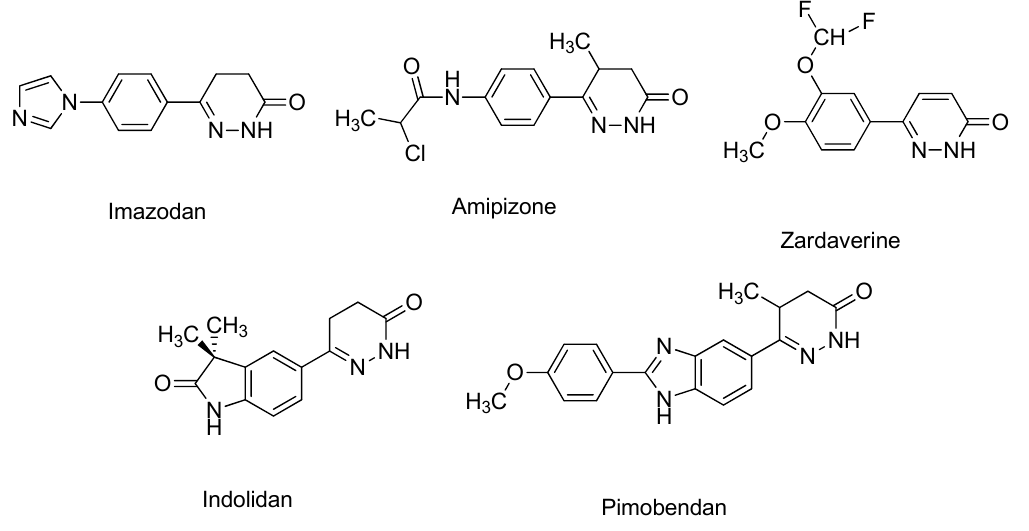
Figure 3. Pyridazinone derivatives in veterinary medicine.